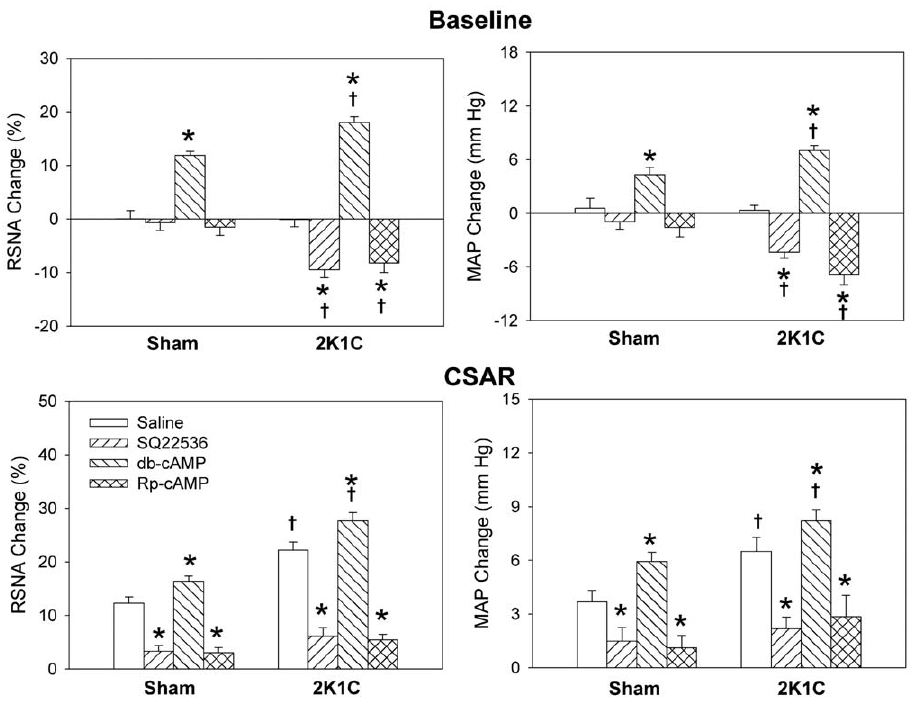
Figure 5. Effects of the PVN microinjection of saline, SQ22536 (2 nmol), db-cAMP (1 nmol) and Rp-cAMP (1 nmol) on the baseline RSNA and MAP and CSAR. The CSAR was evaluated by the RSNA and MAP responses to epicardial application of capsaicin (1 nmol). Values are